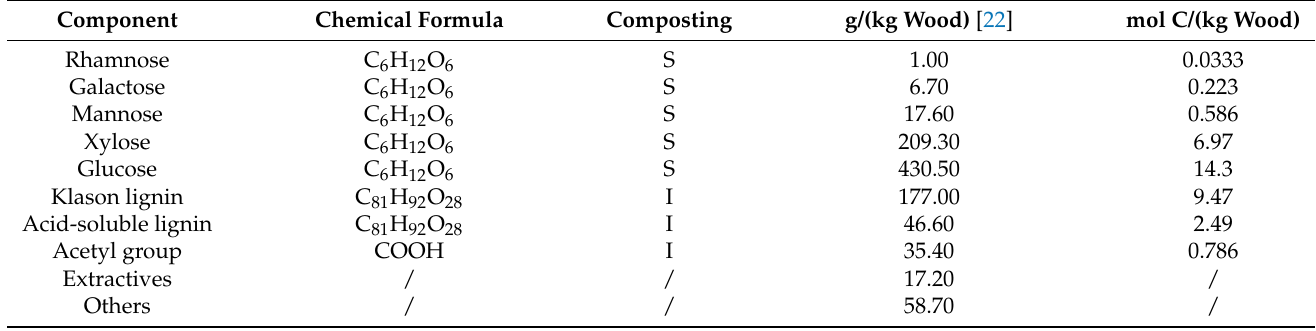
Table 2. Conversion factors of wood characteristics into units of the composting